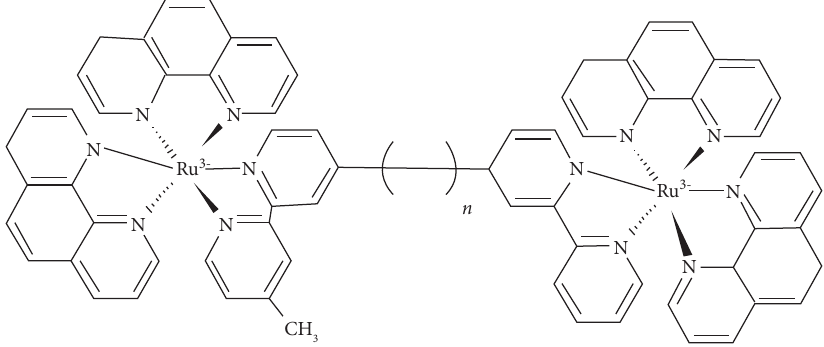
Figure 7: Structure of dinuclear ruthenium (II)